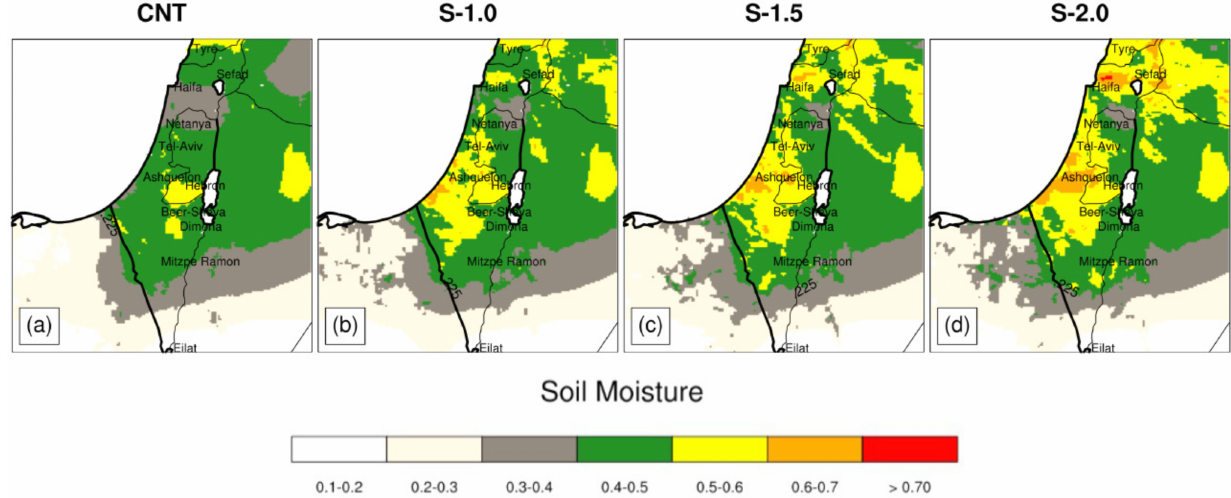
Figure 7. Volumetric soil moisture in the first soil layer (1–10 cm) from four different simulations at 0000 UTC 26 April 2018. In ( a ), GFS initial conditions were used in a WRF simulation, which produced precipitation that wet the ground (the Control). In ( b ), 10-min derived rainfall rate from radar observations was used instead of simulated rainfall to moisten the soil (S-1.0). In ( c ), observed rainfall rate was increased by 50% (S-1.5), while in ( d ) the observed rainfall was twice multiplied (S-2.0). The derived soil moisture ( b – d ) was then used in WRF simulations with soil-atmospheric feedbacks only allowed to affect the surface temperature, but not soil